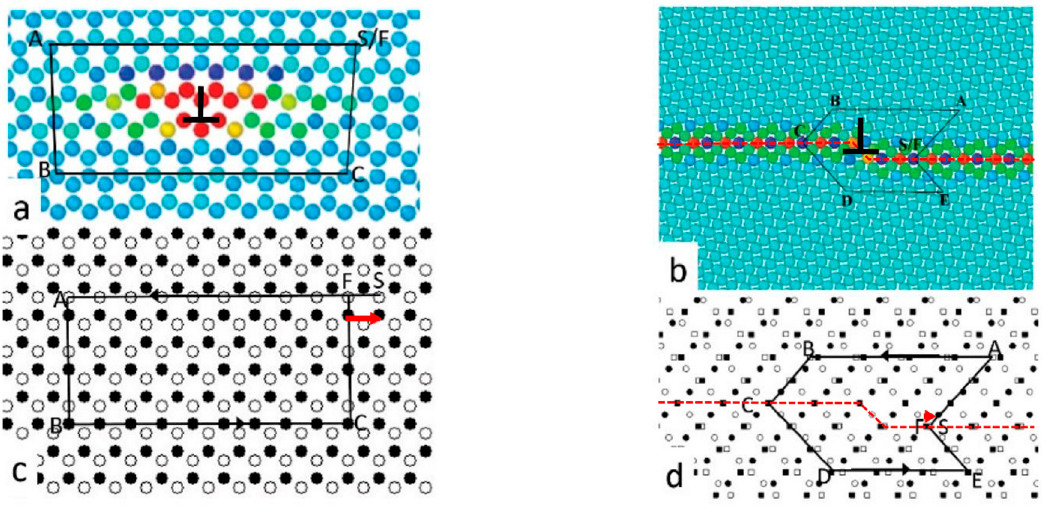
Figure 2. ( a , c ) Edge dislocation in an hcp single crystal with dislocation line along [1]. Crystal dislocation encircled by a Burgers circuit, which is reproduced in the perfect crystal below. Atoms are colored according to their energy. The circuit is plotted anticlockwise from S to F. The Burgers vector of the dislocation is indicated below the closure failure in red. It corresponds to a lattice vector a 0 . (cid:110) (cid:111) Projection in [1] direction. ( b , d ) disconnection in 1012 twin boundary from atomistic simulations. The (cid:110) (cid:111) 1012 twin boundary is indicated by red dashed line. The disconnection produces step in the boundary. The Burgers circuit is reproduced in the dichromatic pattern. It starts in the S point at the black crystal, and continues in white crystal from point C, which is common for both crystals. It continues to the (cid:68) (cid:69) point F. The vector FS is the Burgers vector of the disconnection. Projection in 1210 direction.